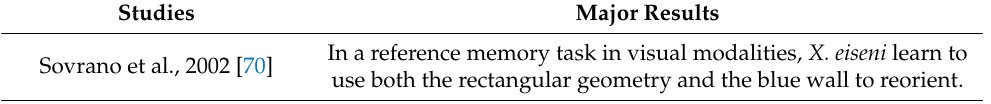
Table 1. Summary of major findings on geometric navigation by fishes, within visual and nonvisual spatial layouts. Working and reference memory tasks are specified to distinguish across behavioral protocols, visual and nonvisual to distinguish across experimental